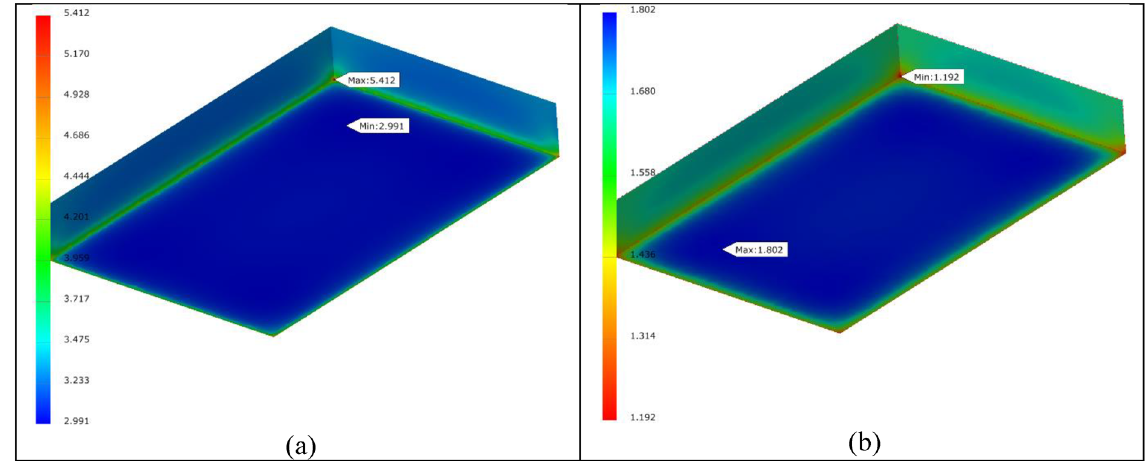
Figure 8. ( a ) Von Mises distribution in the first brick (from the bottom of the stack), loaded with 455 kN (about 3500 bricks). ( b ) Safety factor distribution in the first brick.